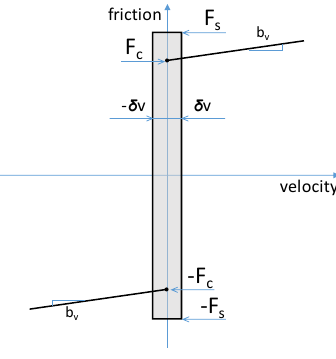
Figure 5. The Karnopp friction model for haptic rendering.